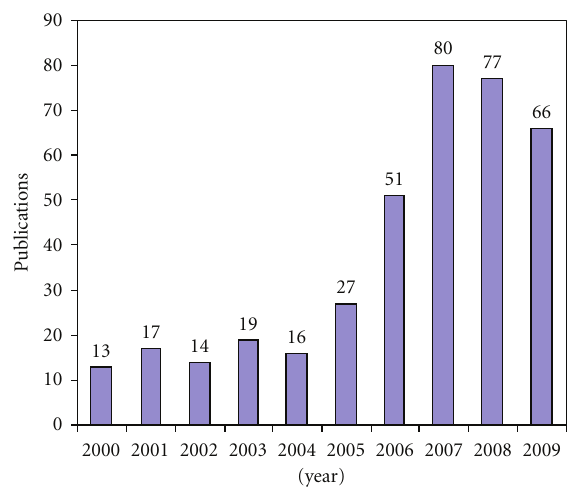
Figure 1: FPGA multiprocessor publications trend (2010 Febru-